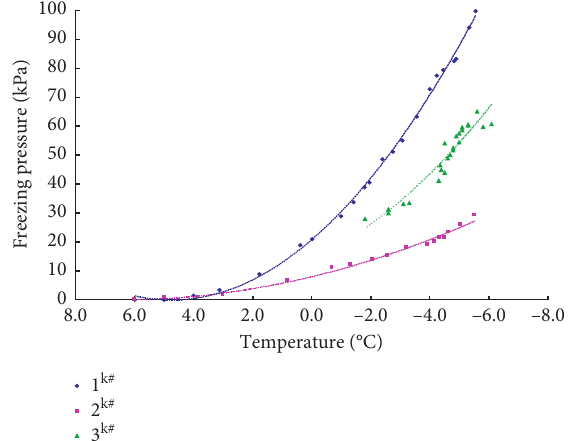
Figure 16: Calculated and measured temperature-freezing pres- sure curves. Table 3: Fitting coefficients. Fitting